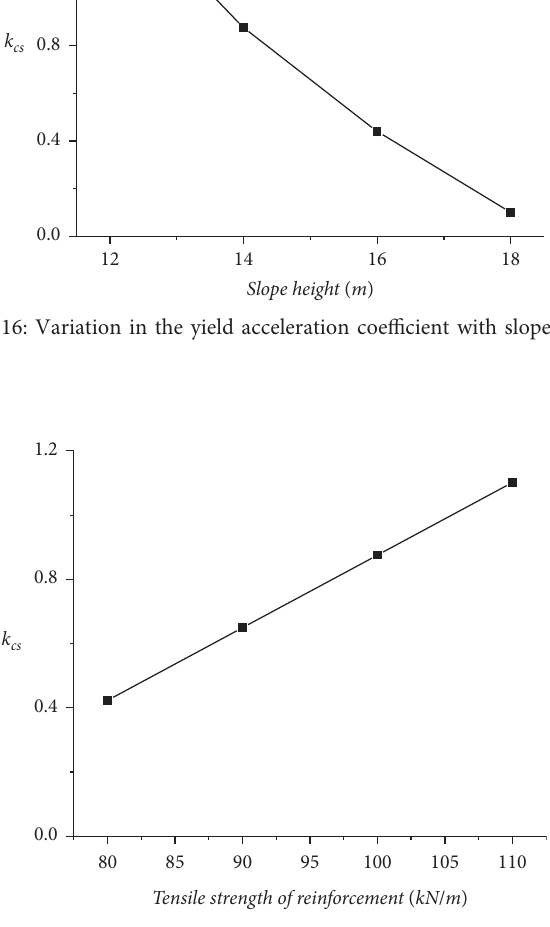
Figure 17: Variation in the yield acceleration coefficient with tensile strength of